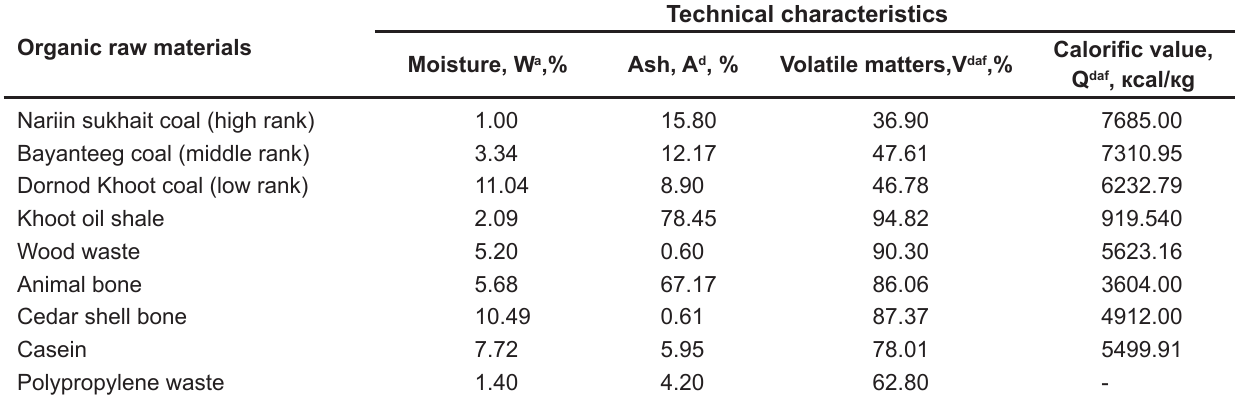
Table 2. Technical characteristics of organic raw materials Technical Organic raw materials